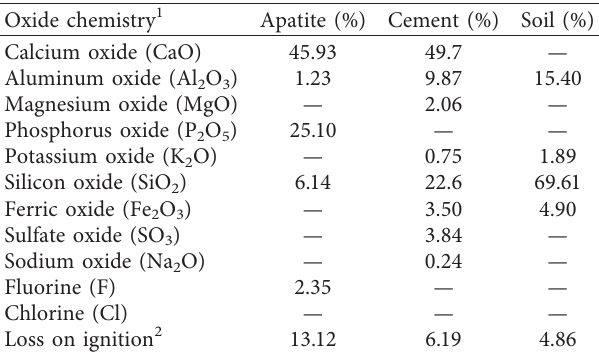
Table 2: Oxide chemistry of cement, phosphate rock, and soil used in this